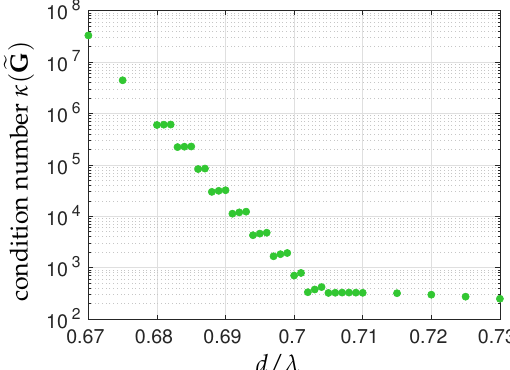
Figure 6. Variations of the condition number κ ( (cid:101) G ) of the regularized modeling matrix (cid:101) G of the cross- shaped array shown in Figure 4 with the shortest spacing d between the 167 elementary